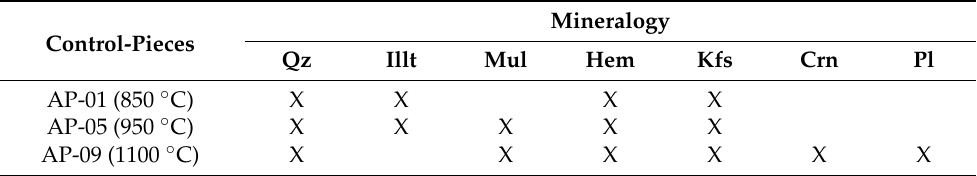
Table 7. Summary of the mineralogical phases of the AP control-pieces. Qz = quartz; Ilt = illite; Mul = mullite; Hem = hematite; Kfs = potassium feldspar; Crn = corundum; Pl = plagioclase, abbreviations according to Whitney and Evans (2010)